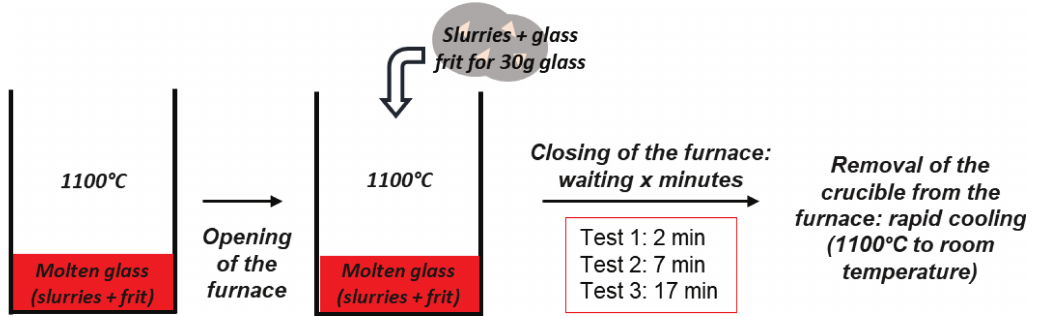
Fig. 5. Principle of the reactivity tests at high temperature.